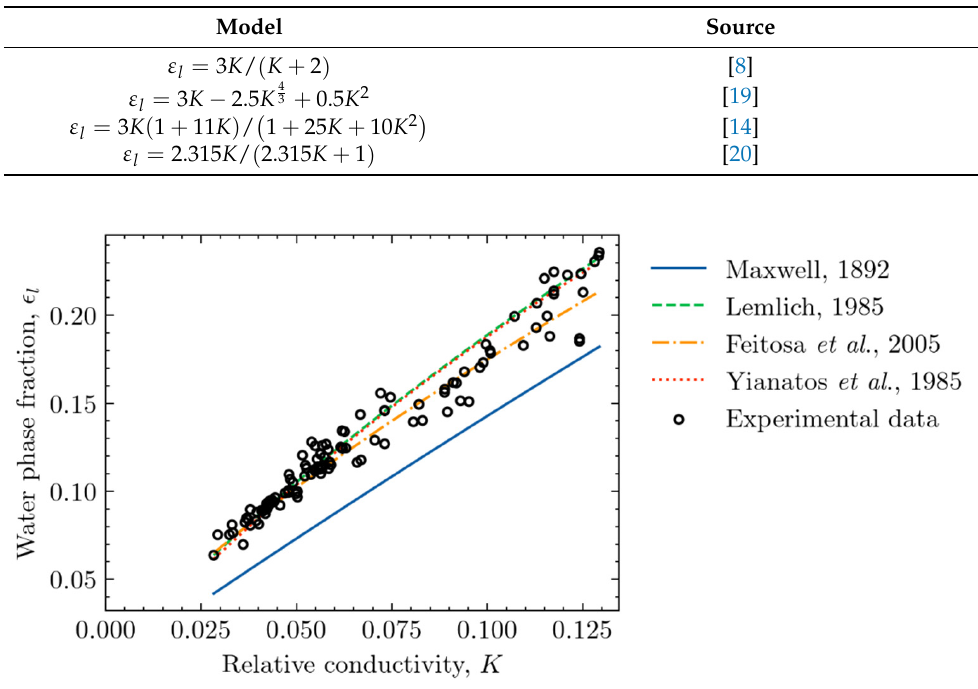
Figure 5. Actual against predicted water phase fraction for kerosene in water emulsion measured by conductivity. Table 3. Models from the literature relating relative conductivity to water content in a dispersion.